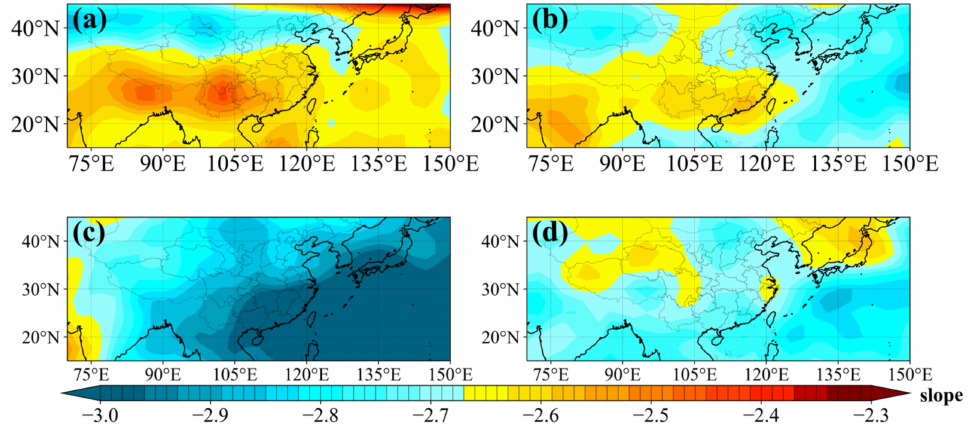
Figure 5. Distribution of average S values in ( a ) DJF, ( b ) MAM, ( c ) JJA, and ( d ) SON.